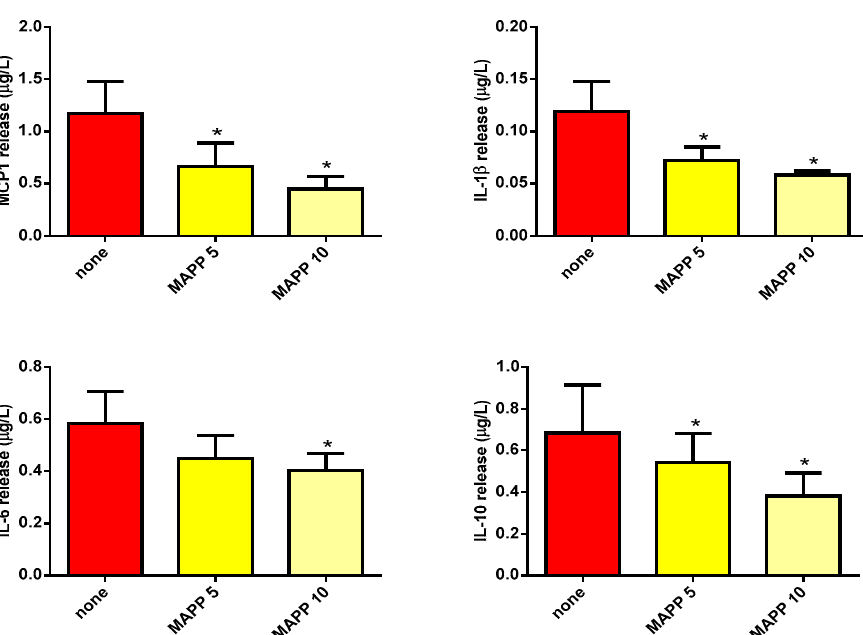
Figure 3. MCP1, IL-1 β , IL-6, and IL-10 release promoted by LDL( − ) in human monocytes in the presence or absence of MAPP. Monocytes were incubated with LDL( − ) (60 mg apoB / L) in the absence of MAPP (red bars) or in the presence of MAPP at 5 µ M (yellow bars) and 10 µ M (light yellow bars). After 20 hours of incubation, cytokine release was measured by ELISA. Results are expressed as mean ± SD ( n = 5), * vs. the absence of inhibitor, p < 0.05.